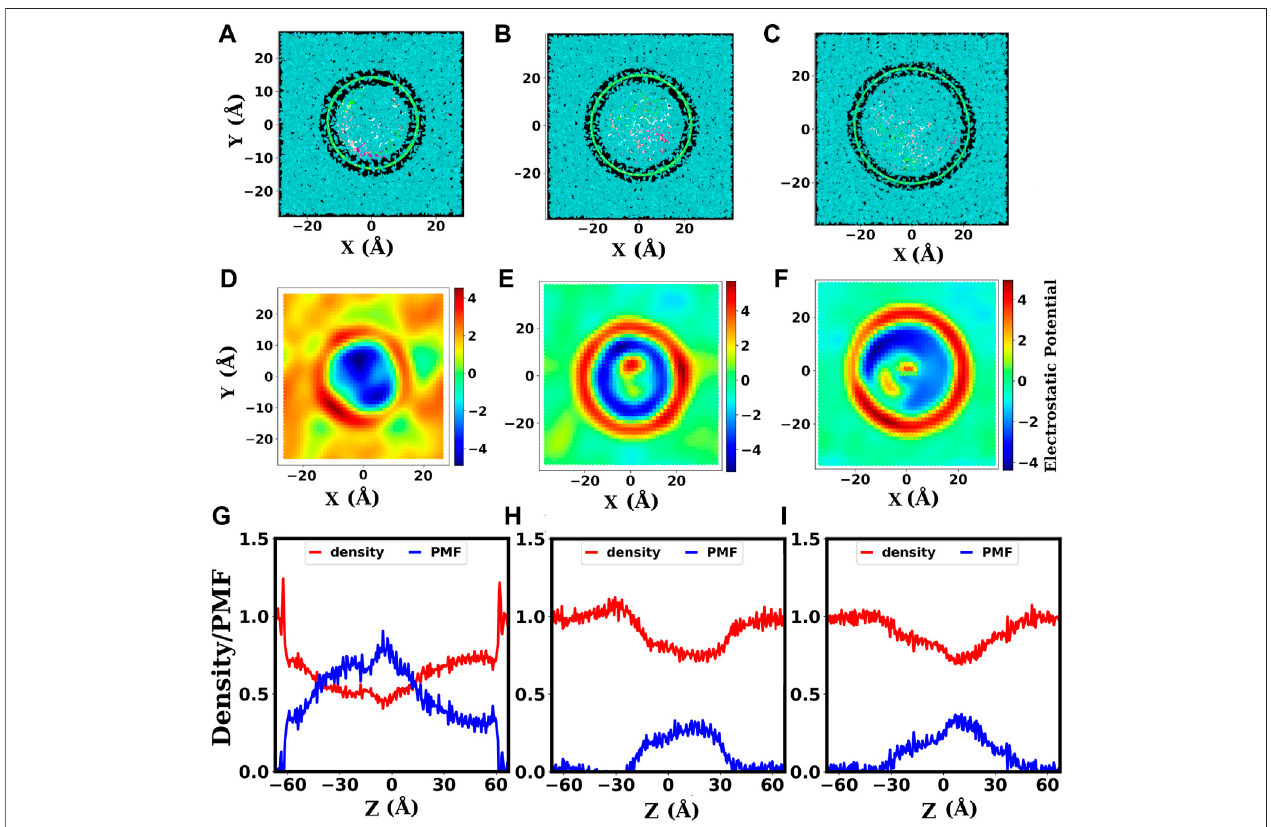
FIGURE 6 | The electrostatic potential maps and axial density of water inside SWCNTs. (A – C) : Cross-sectional view (from the top) of the systems with dsDNA insideSWCNTsofdiameters2.71,3.25,4.07 nm,correspondingtochiralityindices(20,20),(24,24),and,(30,30),respectively.The fi nitegapseenbetweentheSWCNT and water surfaces depicts the hydrophobic nature of the SWCNT surface. (D – F) : Electrostatic potential maps for the systems with dsDNA inside SWCNTs of chirality indices (20,20), (24,24), and, (30,30), respectively. The color scale bar gives the electrostatic potential in units of K B T / e . (G – I) : Axial density of water, showing the variation of the density of con fi ned water along the length of the SWCNT, and the corresponding PMF for SWCNTs of chirality indices (20,20), (24,24), and (30,30), respectively. The PMF is in units of k B T . The unit of axial density ( ϱ ) of water is g/cm 3 .